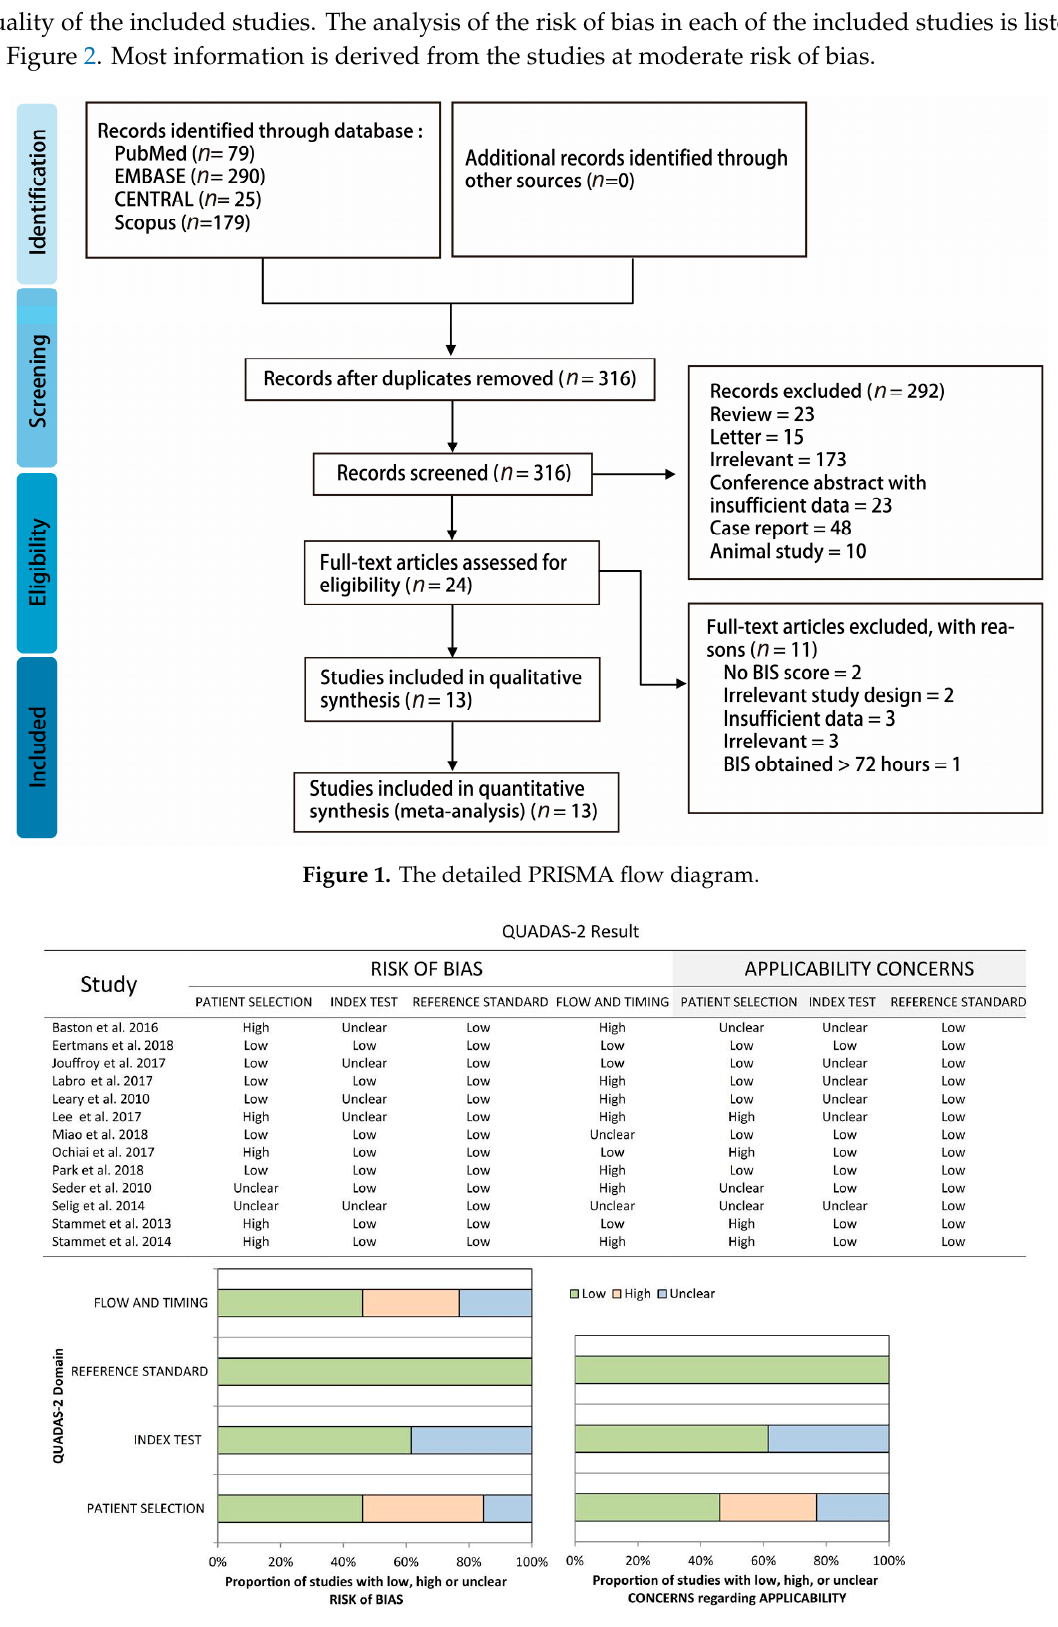
Figure 2. The quality and risk of bias assessment of the included studies. QUADAS-2: Quality Assessment of Diagnostic Accuracy Studies-2.